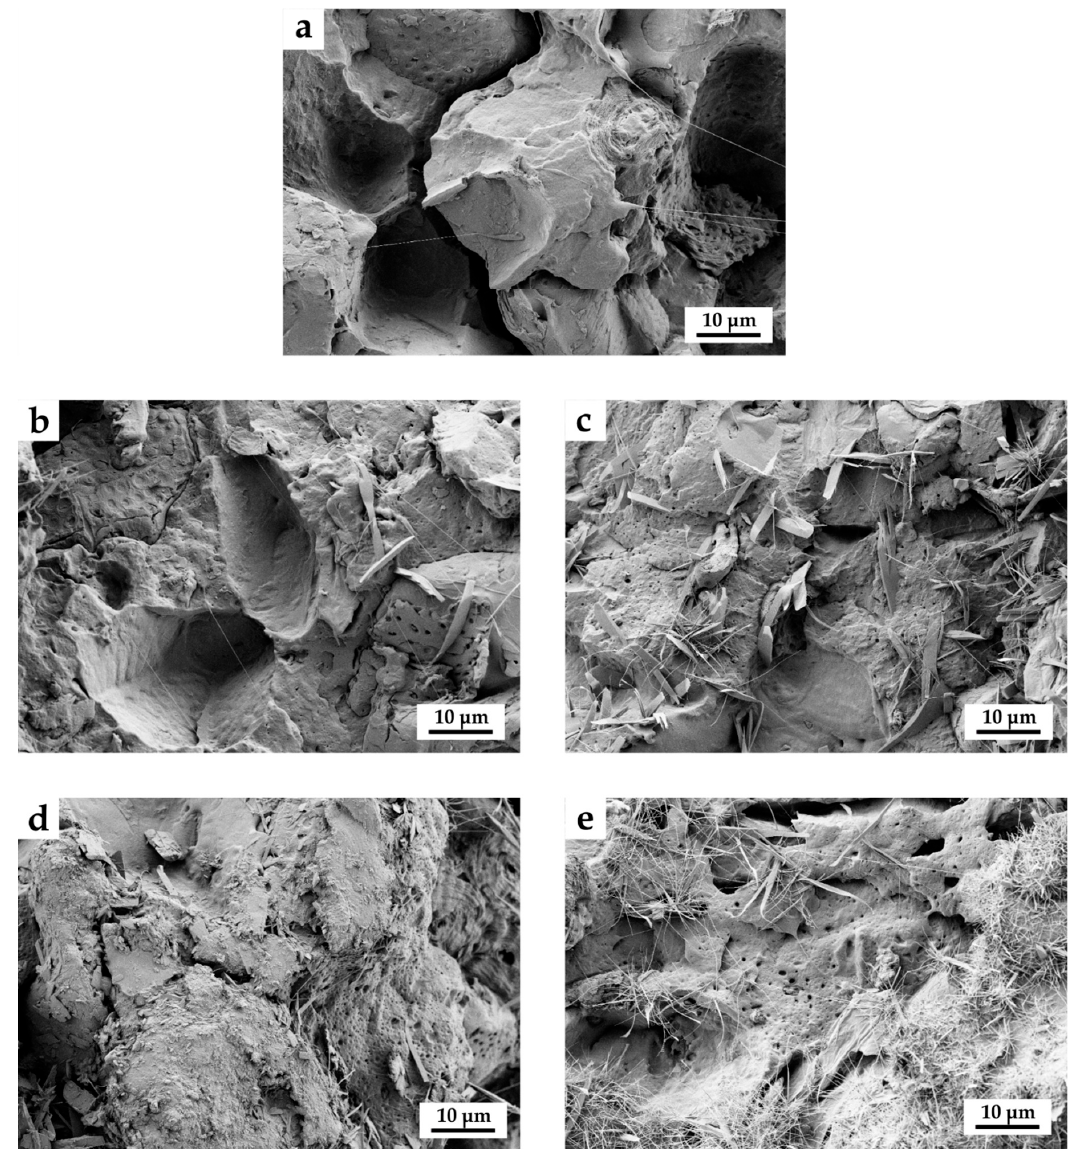
Figure 1. Field emission scanning electron microscopy (FESEM) images of the surface fracture of PBS/ASF composites, uncompatibilized and MLO-compatibilized taken at 1000 × : ( a ) PBS + ASF; ( b ) PBS + ASF + 2.5MLO; ( c ) PBS + ASF + 4.5MLO; ( d ) PBS + ASF + 7.5MLO; and ( e ) PBS + ASF + 10MLO. Scale markers of 10 µm.